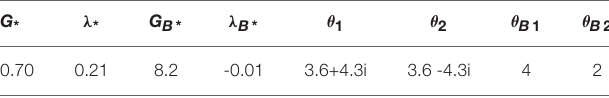
TABLE 3 | Fixed-point results from Becker and Reuter (2014) for the “dynamical” couplings in the Einstein-Hilbert truncation and their background counterparts. G *